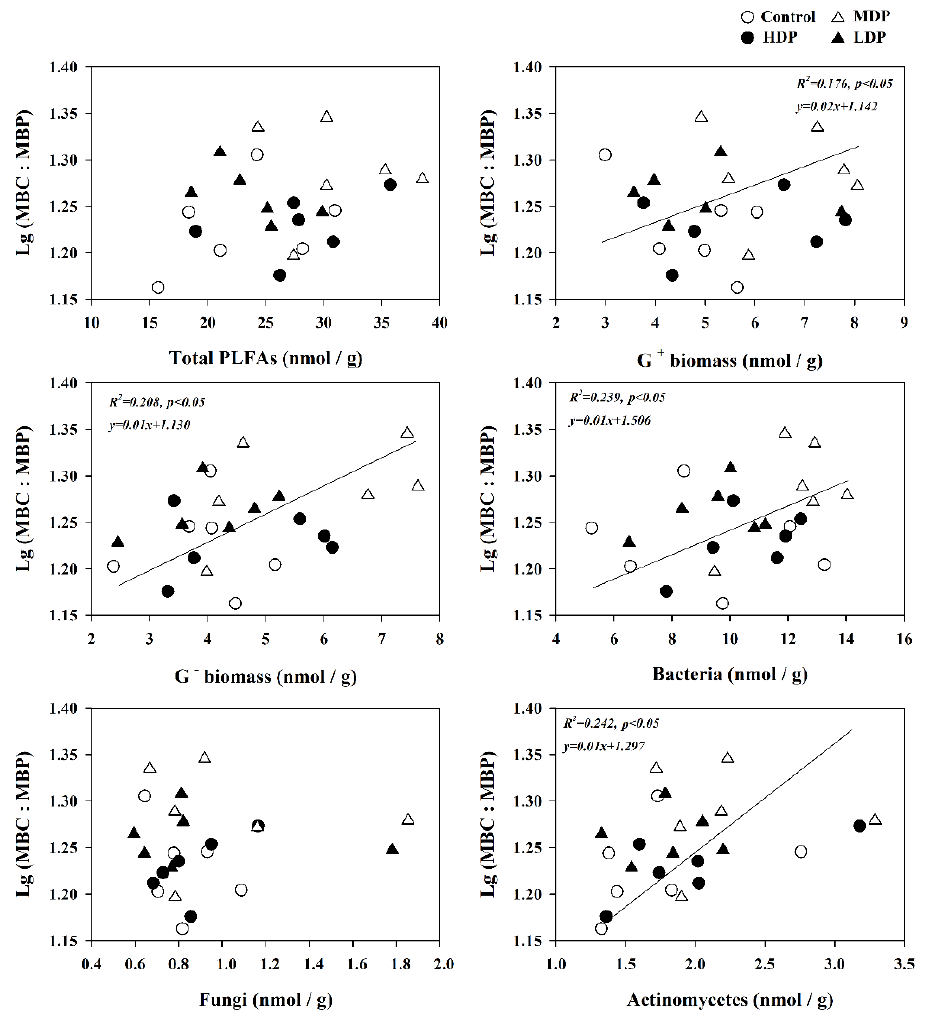
Figure 4. Relationships between MBC:MBP ratio and soil microbial groups in L. principis-rupprechtii plantations with different density.